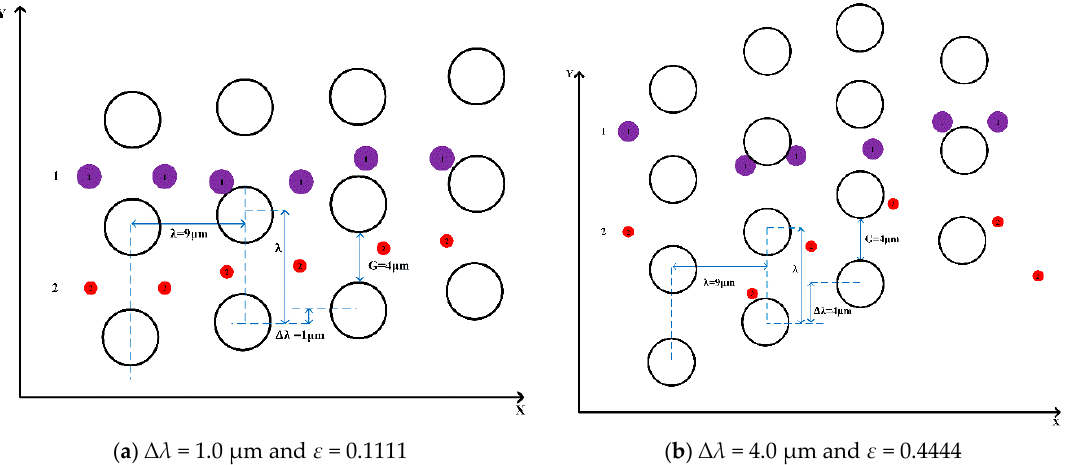
Figure 4. Two types of microspheres with diameters of 1.4 µm and 3.0 µm, marked in red and purple. ( a ) The trajectories of the microspheres are “displacement mode” in a circular pillar; the different row shift fraction is ε = 0.1111 and ∆ λ = 1.0 µm. ( b ) The trajectories of the microspheres are in “zigzag mode” in a circular pillar; the row shift fraction is ε = 0.4444 and ∆ λ = 4.0 µm.